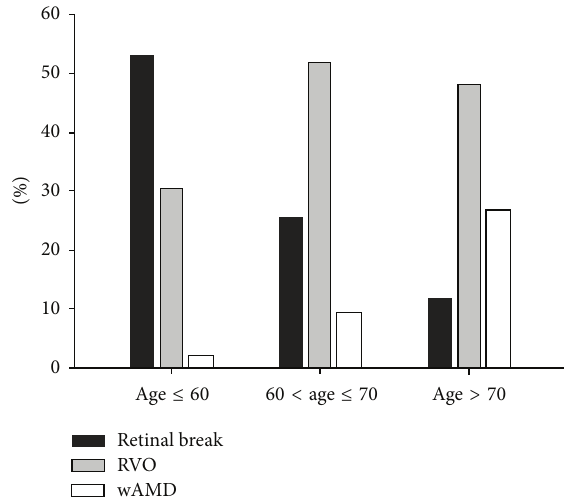
Figure 1: Causes of acute-onset vitreous hemorrhage of unknown origin according to age. Among patients aged ≤ 60 years, retinal break was the main cause of acute-onset VH of preoperatively unknown origin. Moreover, the proportion of cases of acute-onset VH of preoperatively unknown origin that was due to retinal break declined with age. In contrast to retinal break, the proportion of vitreous hemorrhage due to wAMD increased with age. Among patients aged > 60 years, RVO was the most common cause of acute- onset VH of preoperatively unknown origin. RVO, retinal vein occlusion; wAMD, wet age-related macular degeneration.